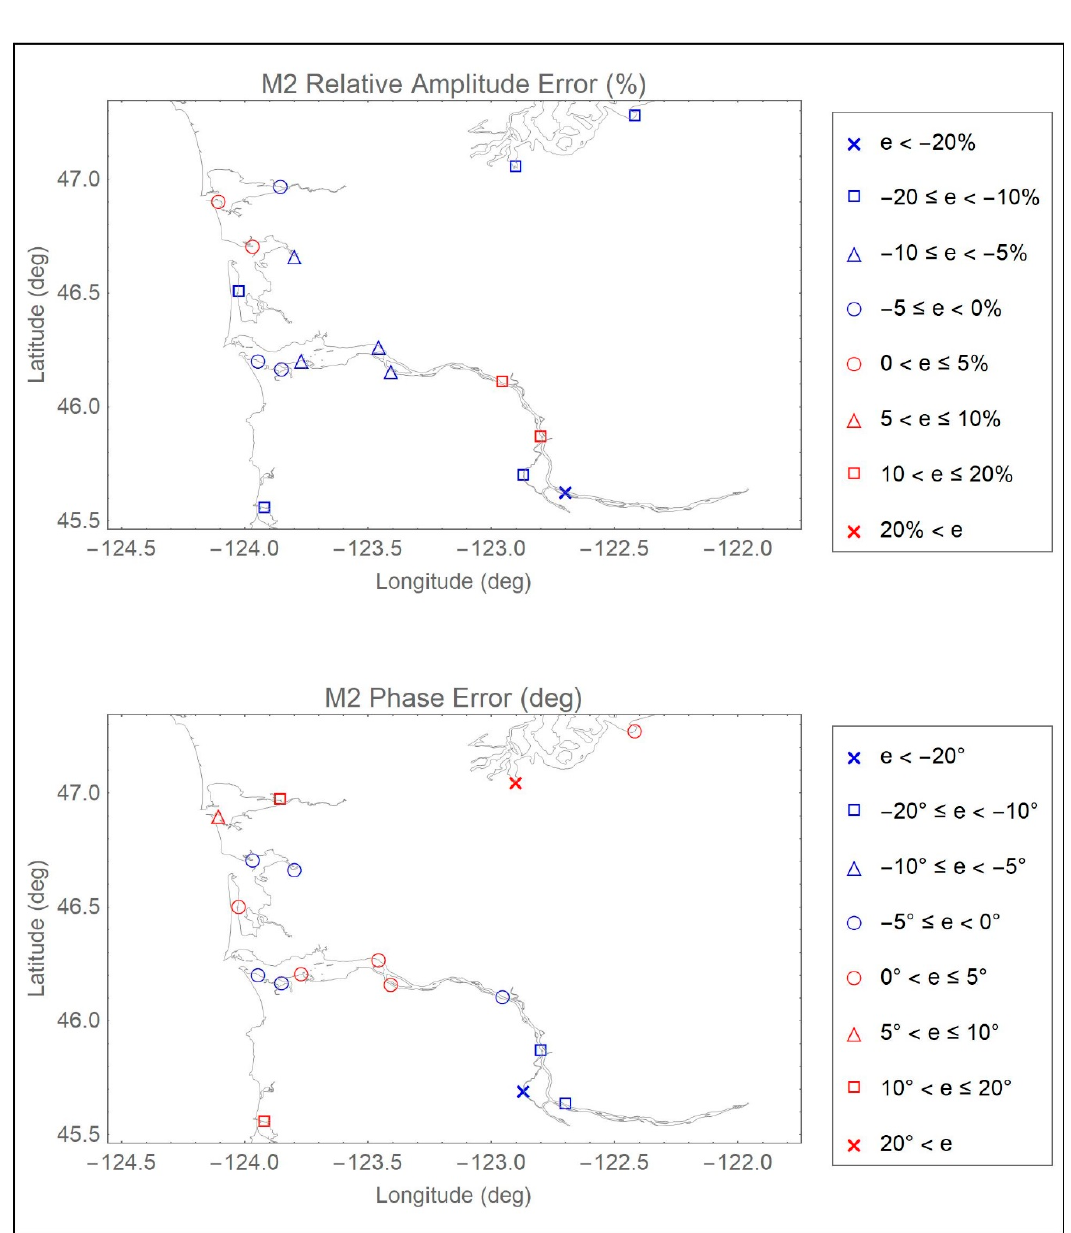
Figure A18. Distribution of ENPAC15 relative amplitude (%) and absolute phase (deg) errors for the M 2 constituent: Oregon and Washington coast view.